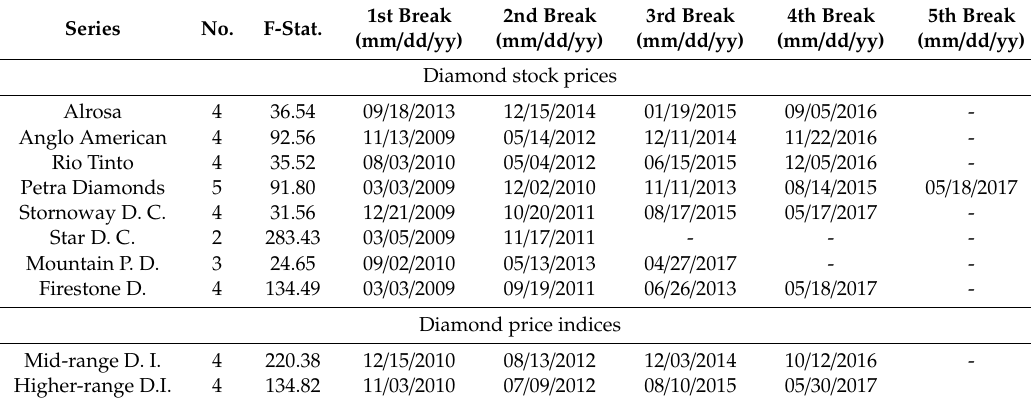
Table 5. Bai Perron test statistics for diamond stock price series and diamond